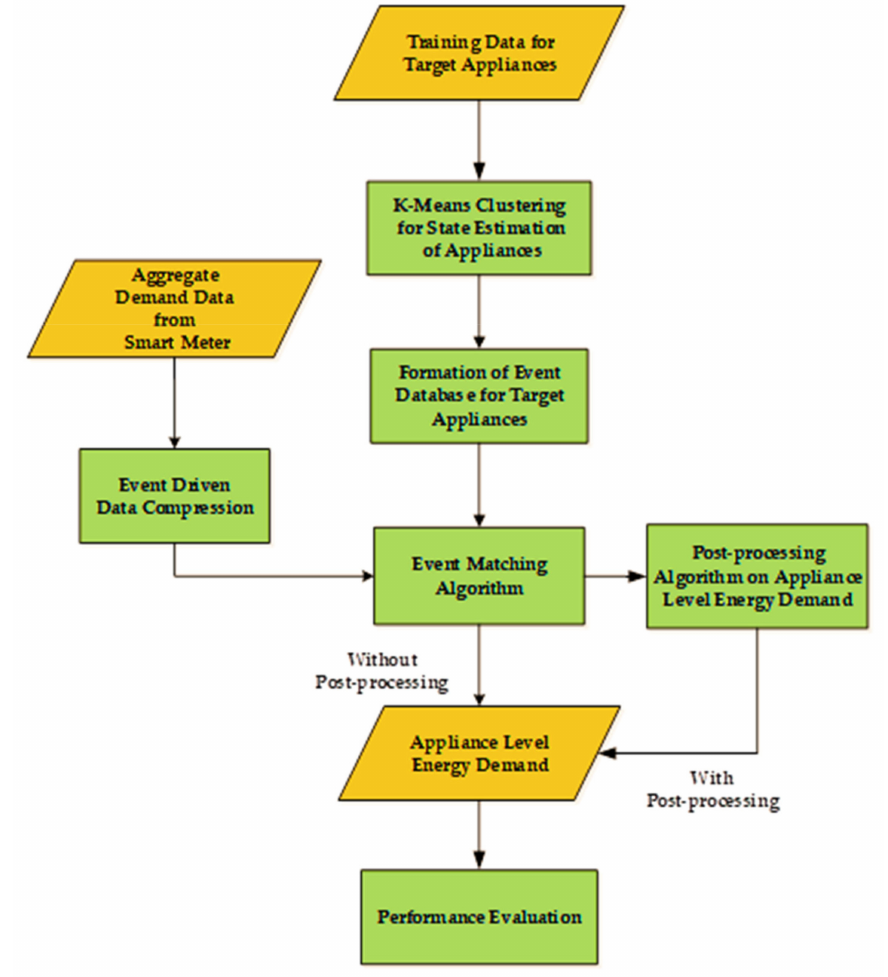
Figure 3. Methodology flowchart for the proposed